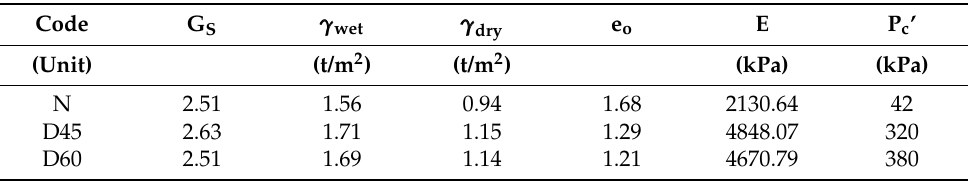
Table 7. Specific gravity, density, void ratio, modulus of elasticity and preconsolidation stress for N, D45 and D60 after